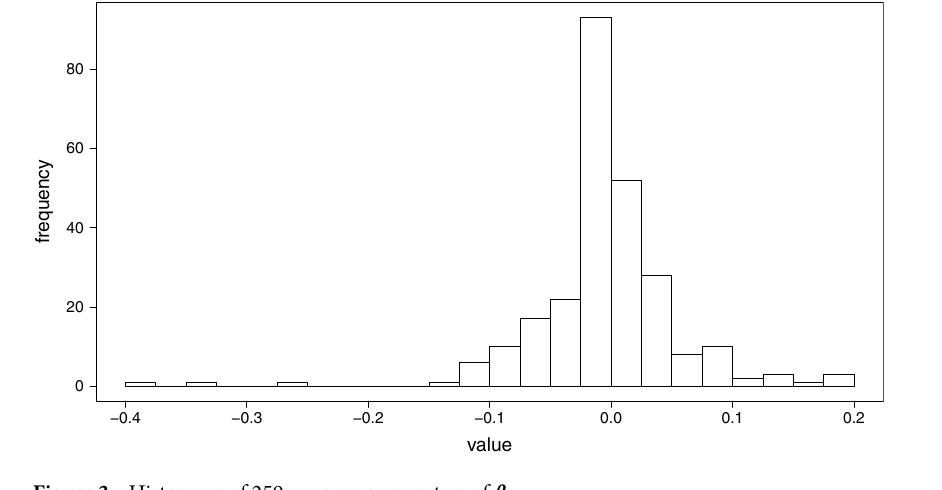
Figure 3. Histogram of 259 nonzero parameters of β